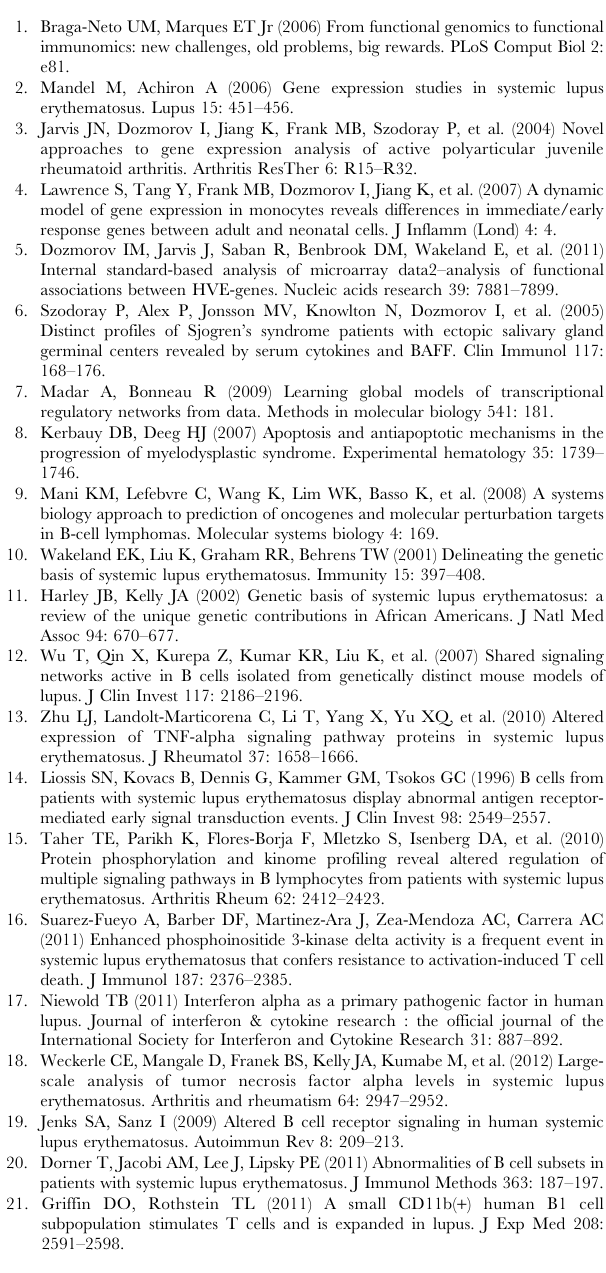
File S2 Table S3, Differences in dynamic gene expression profiles between phenotypic groups. Genes marked with blue are overexpressed in normal control samples, marked with red are overexpressed in pathological samples, bold symbols are used for genes uniquely dynamical in one group and stabile or not expressed in another. The lines on the graph are representative of the two SLE patient (red) and two control (blue) cell lines